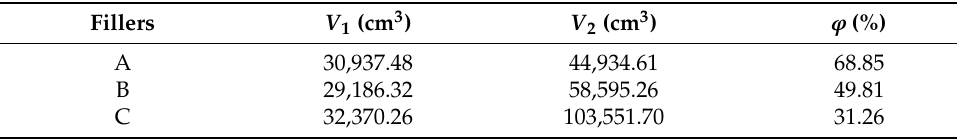
Table 2. The permeability of the fillers.